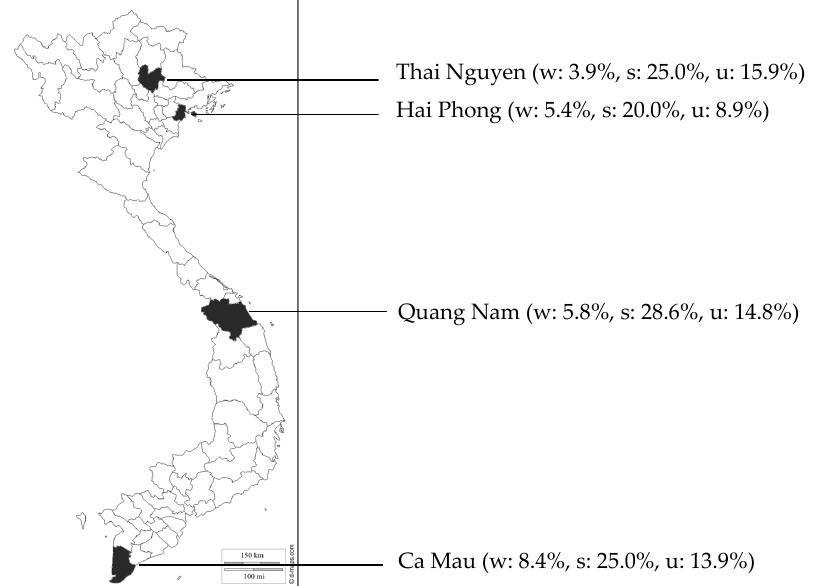
Figure 1. Provinces selected in the pilot and their malnutrition prevalence in 2013. With w: wasting rate, s: stunting rate, and u: underweight rate.